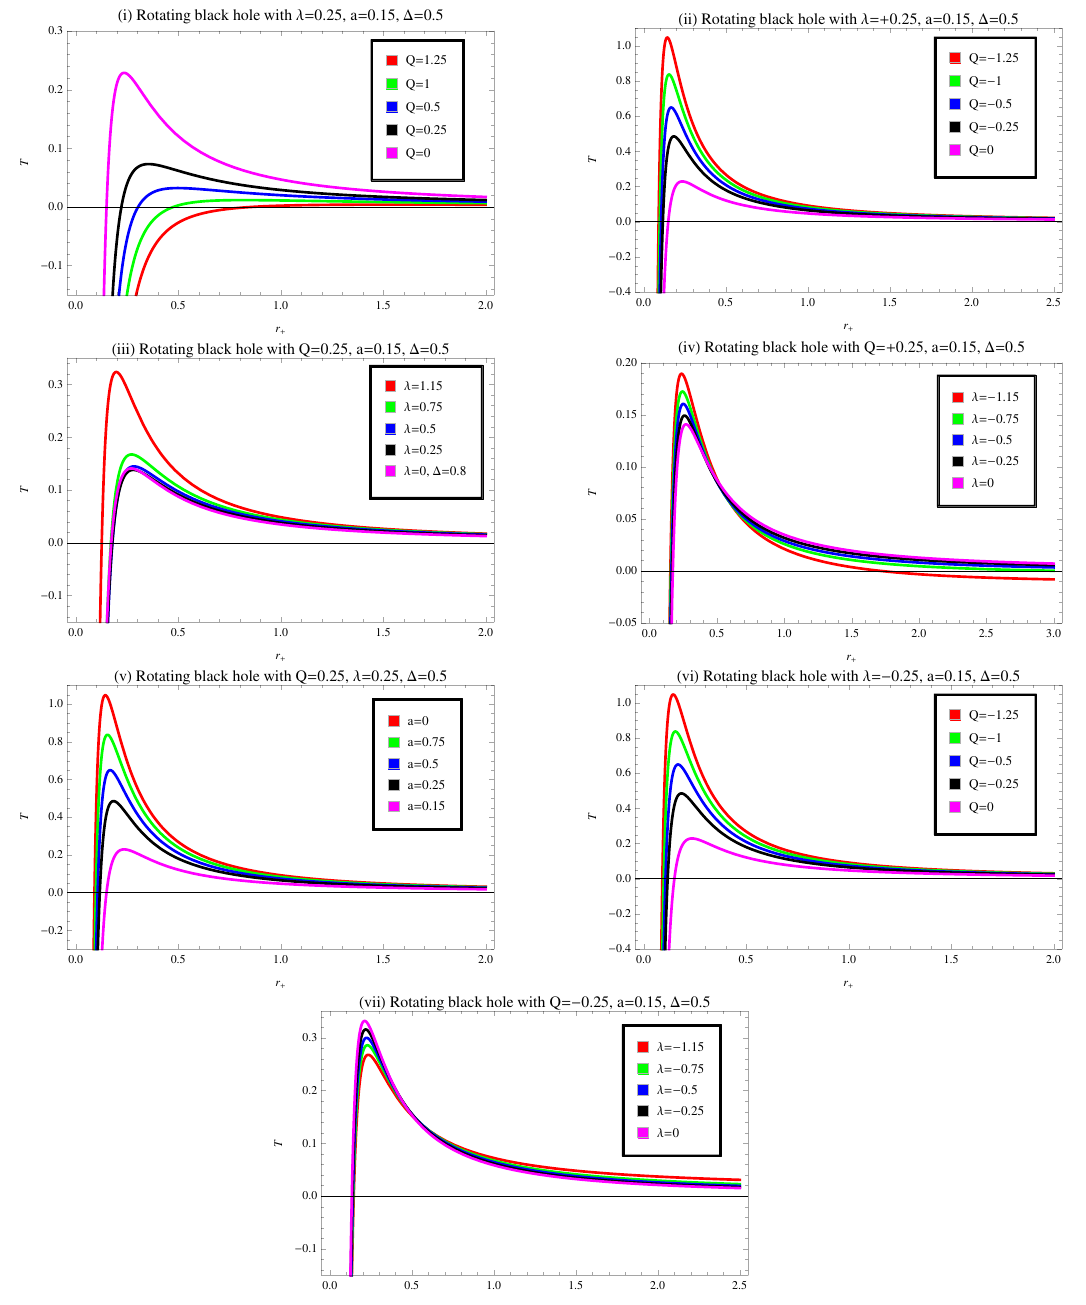
H i L Rotatingblack holewith Λ= 0.25, a = 0.15, D= 0.5